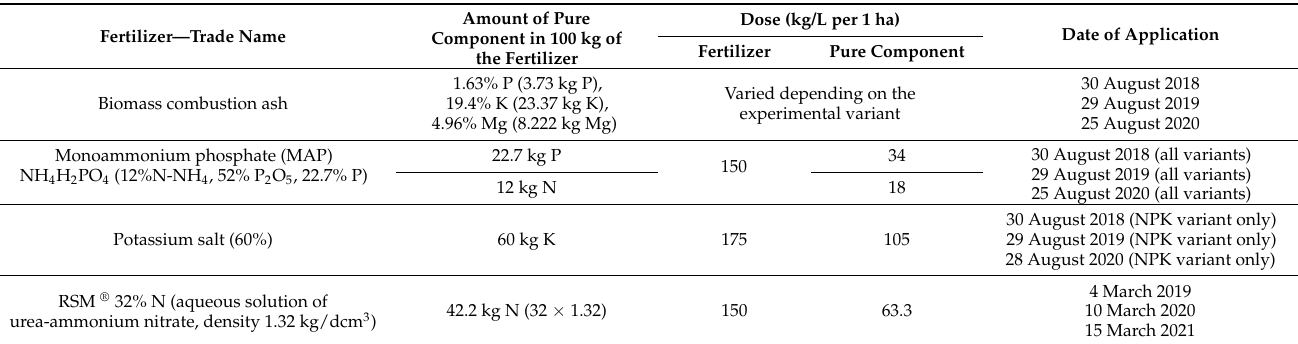
Table 1. Fertilizers used in the two-field experiment on podzolic and chernozem soils in